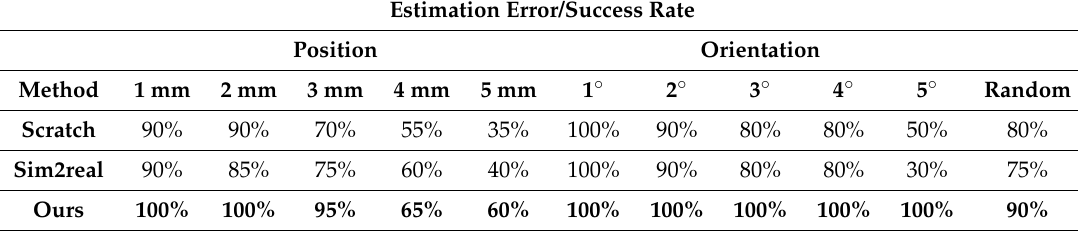
Table 3. Comparison of learning from scratch, straightforward sim2real, and sim2real + retraining (ours) with different degrees of goal-position uncertainty error. Test performed during 3D-printed cuboid-peg insertion task.